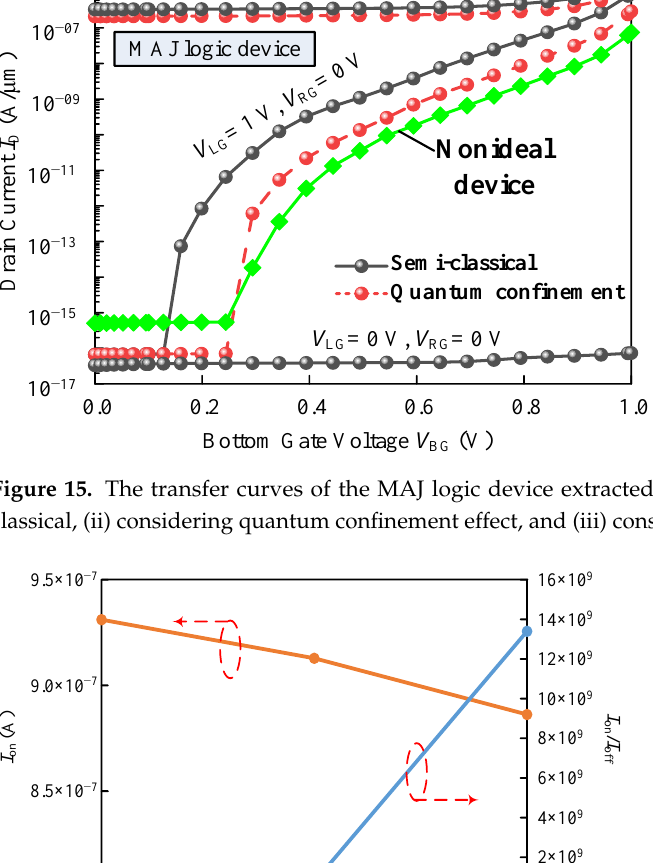
Figure 15. The transfer curves of the MAJ logic device extracted by TCAD simulation: (i) semi-clas- sical, (ii) considering quantum confinement effect, and (iii) considering nonideal effects.